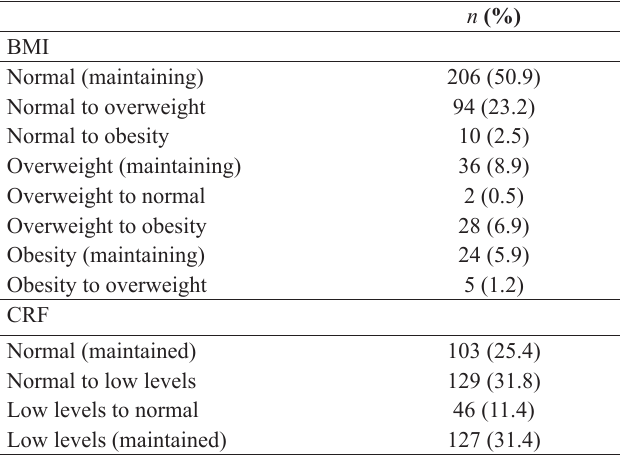
Table 2. Nutritional status and CRF at 4-year follow-up.